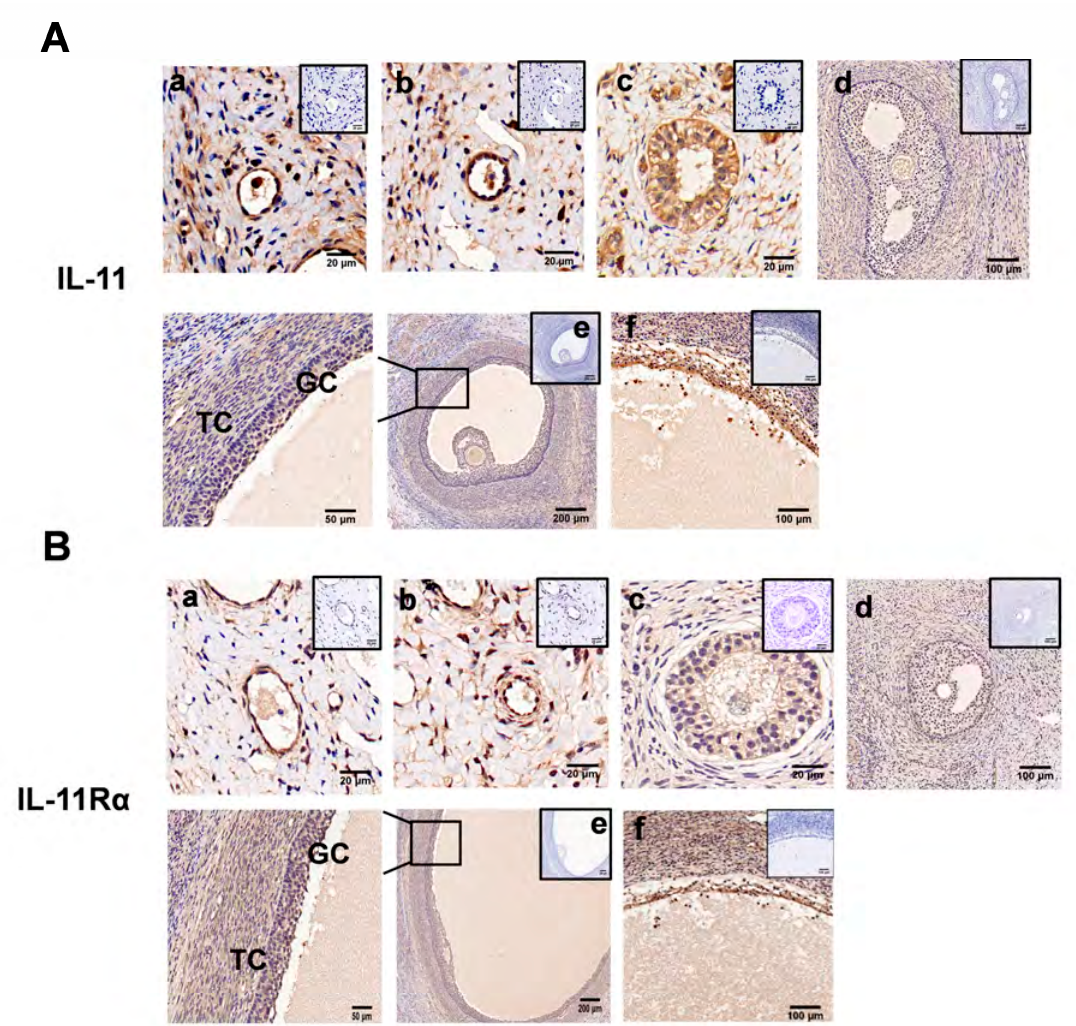
Figure 2. Immunohistochemical staining of IL-11 and IL-11R α in bovine ovary. IL-11 ( A ) and IL-11R α ( B ) were detected in primordial ( a ); a single layer of flattened GCs, primary ( b ); a single layer of cuboidal GCs, secondary ( c ); multiple layers of cuboidal GCs, small antral ( d ); large antral ( e ); and atretic follicles ( f ). GC, granulosa cells; TC, theca cells. Negative controls were incubated in the absence of the primary antibody and are presented in the top-right corner. Scale bars correspond to 20 ( a – c ), 50 (enlarged e ), 100 ( d , f ), and 200 μ m ( e ). Immunofluorescence staining further indicated that IL-11, IL-11R α , and gp130 exhib-